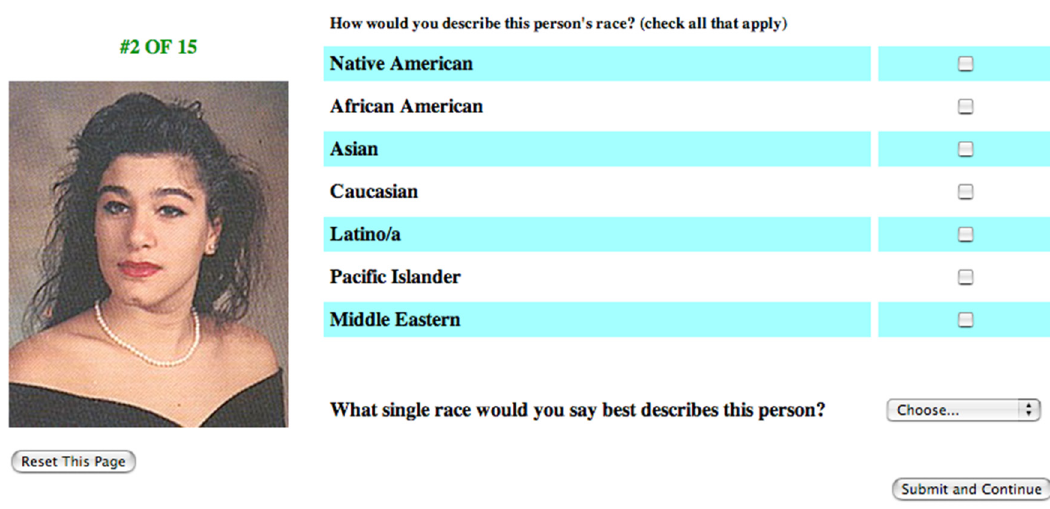
Figure 2. Survey screenshot.